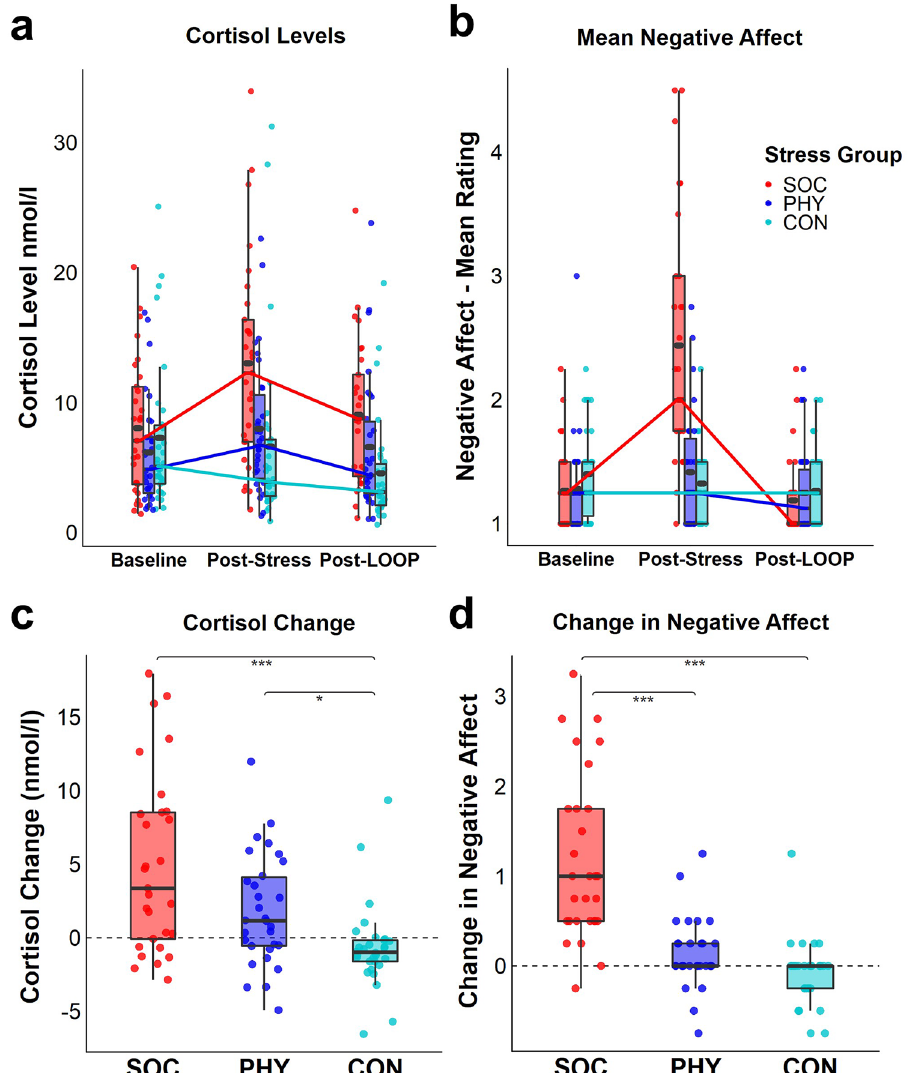
Figure 2. ( a ) Cortisol levels over the course of the experiment separately for the three stress groups (social- evaluative stress [ n = 29] vs. physical stress [ n = 30] vs. no stress [ n = 30]). Lines connect group medians. Group means are depicted as gray ovals within the box. ( b ) Mean negative affect ratings (embarrassment, anger, frustration and perceived stress) over the course of the experiment separately for the three stress groups depicted as in (a) ( c ) Change in saliva cortisol levels after stress induction (post-stress T2 CORT − baseline T1 CORT ), ( d ) Change in negative affect (post-stress T2 AFF − baseline T1 AFF ), SOC = Social-evaluative stress group, PHY = Physical stress group, CON = no stress control group. Line inside box: median, lower/upper box hinges: 25th and 75th percentile, lower/upper box whiskers: smallest/largest value within 1.5 × inter-quartile range from hinges, * p < 0.050, *** p <